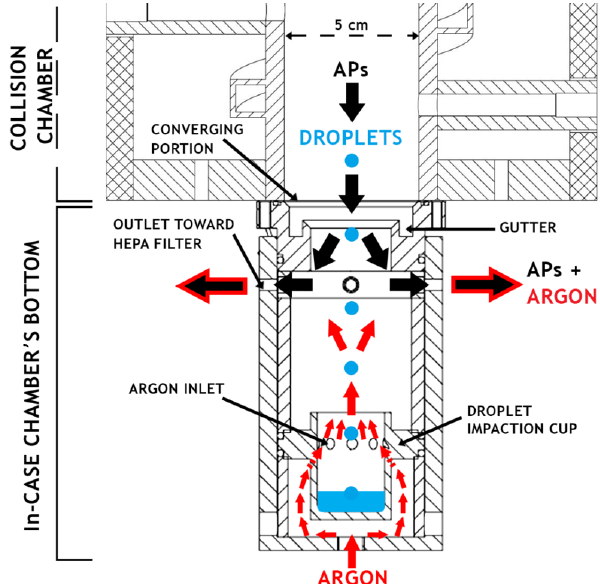
Figure 2. In-CASE setup to study the influence of relative humidity. Colours represent different functions. Red represents upward Argon flow against AP pollution in the droplet impaction cup. Purple rep- resents AP (and Argon) evacuation toward the HEPA filter. Orange represents AP, generation, selection and neutralisation. Black repre- sents surplus evacuation and differential mobility analyser (DMA) flow rate control. Brown represents droplet radius measurement. All the key features of the setup are detailed in Table 2.